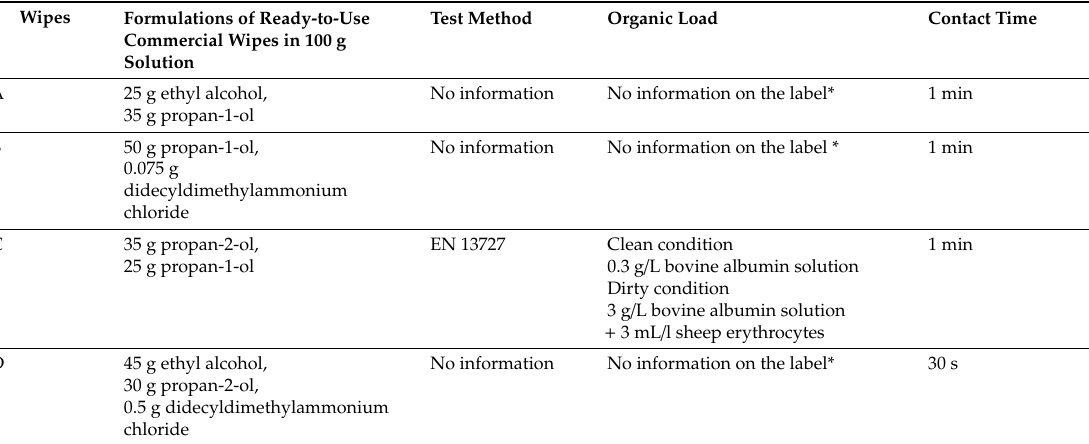
Table 1. Formulations of the ready-to-use commercially available wipes according to the